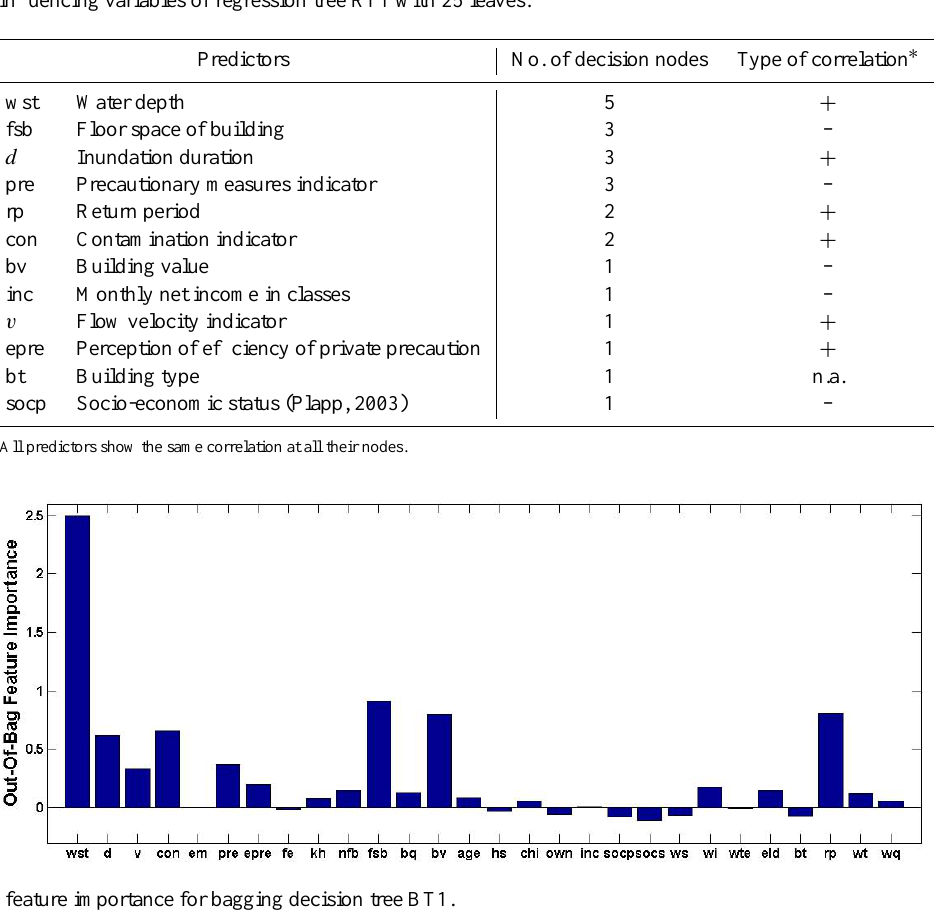
Fig. 6. Out-of-bag feature importance for bagging decision tree